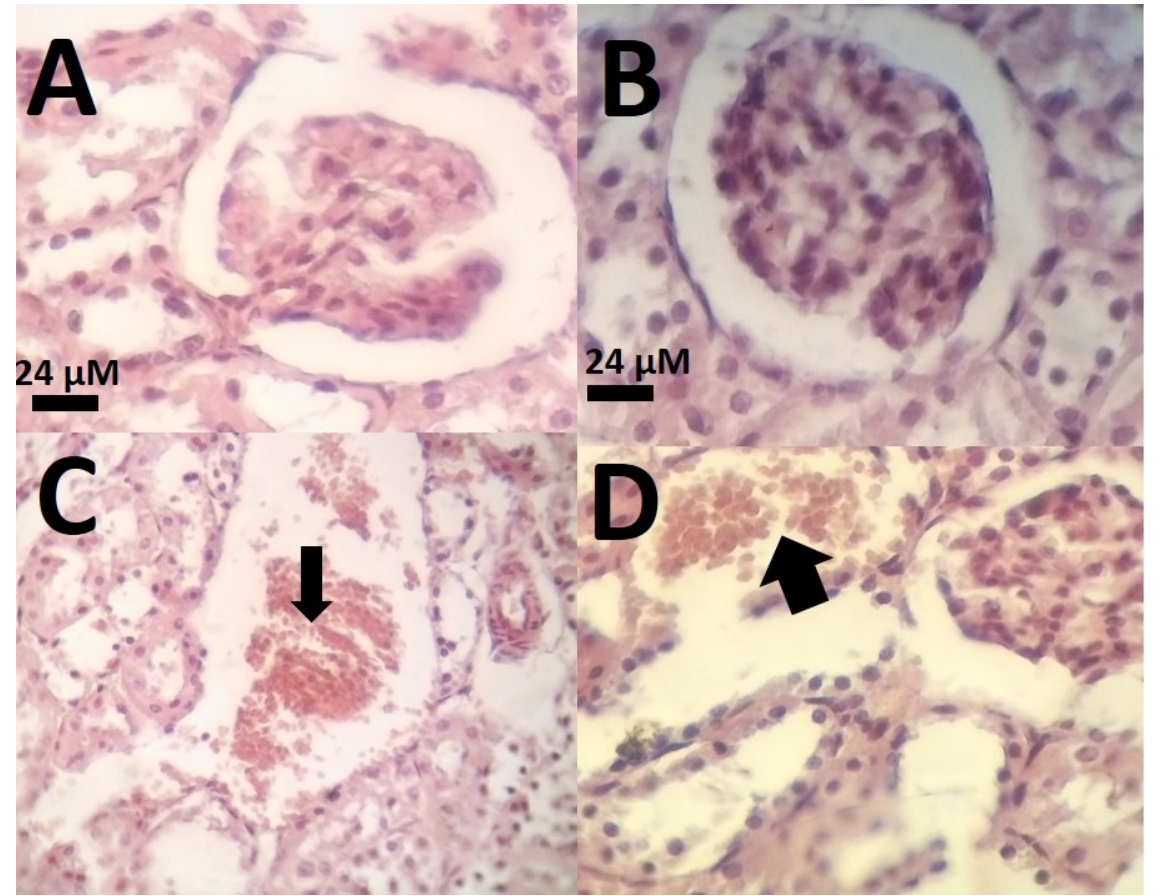
Figure 8. ( A ) Kidney micrograph of a normal control rat, showing normal glomerulus and normal tubules. ( B ): renal micrograph of a rat treated with curcumin microemulsions at a 30 mg/kg dose with normal kidney structure. ( C ): kidney of a thioacetamide-treated rat at a dose of 30 mg/kg; extensive bleeding is present (arrow). ( D ): A kidney PAS-stained section of a thioacetamide-intoxicated rat treated with curcumin microemulsions at a dose of 30 mg/kg shows a reduction in blood congestion in the kidney (arrow). PAS staining. (40× magnification).